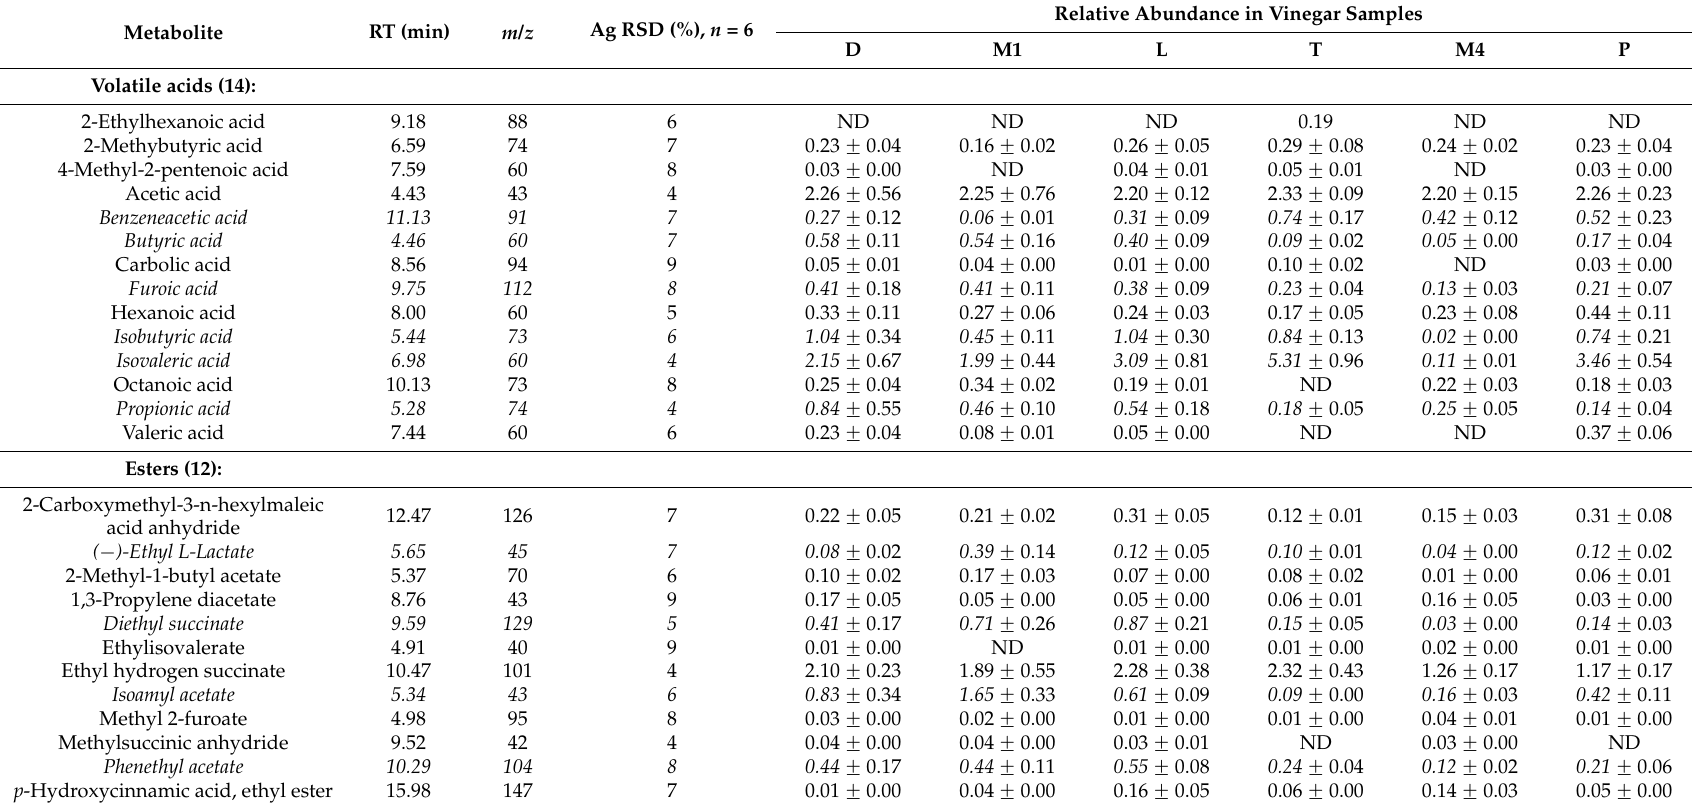
Table 2. Relative abundance of volatile metabolites in commercial balsamic